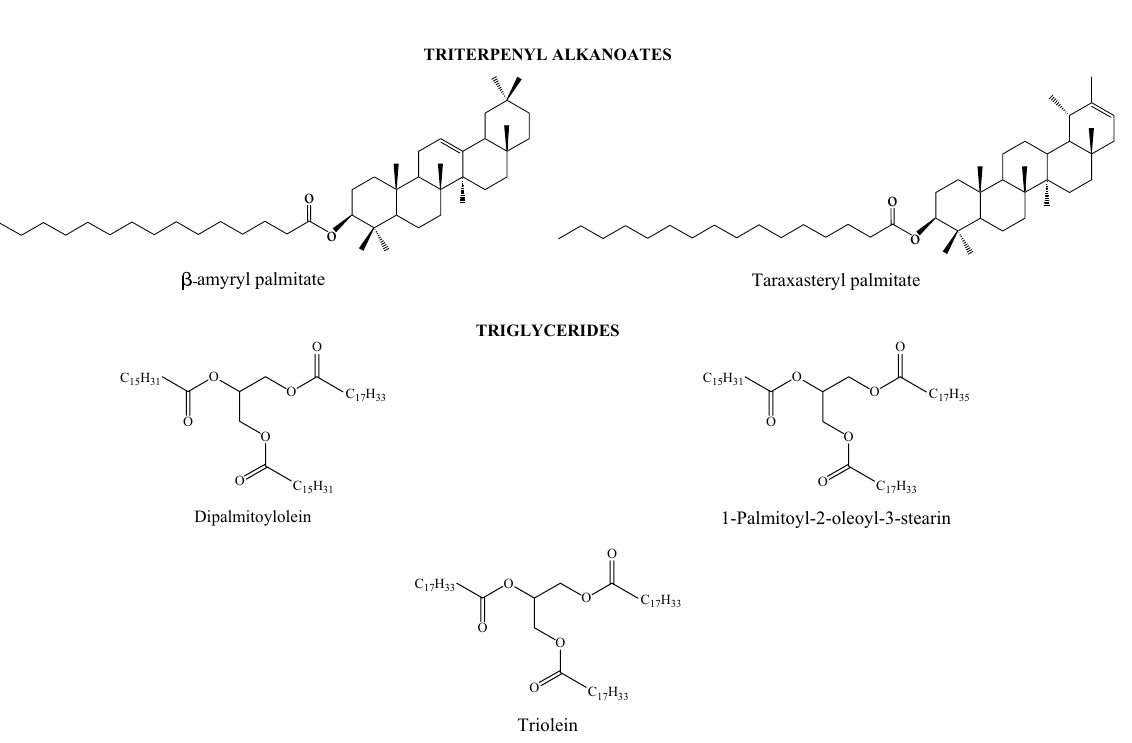
Fig. 4–Structuresofsomecompoundsrepresentativeofthehomologousseriesoftriterpenolsesterifiedtolongchainfattyacidsandoftriglycerides in smoke extract from